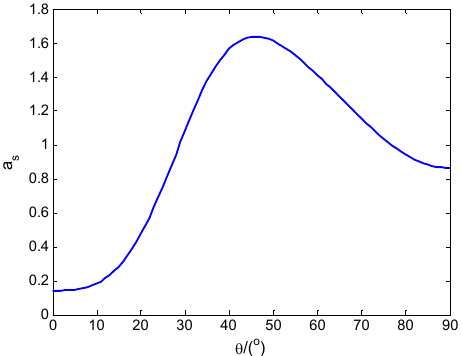
Figure 2. Damping parameter factors (a s ) vs. ply angles.